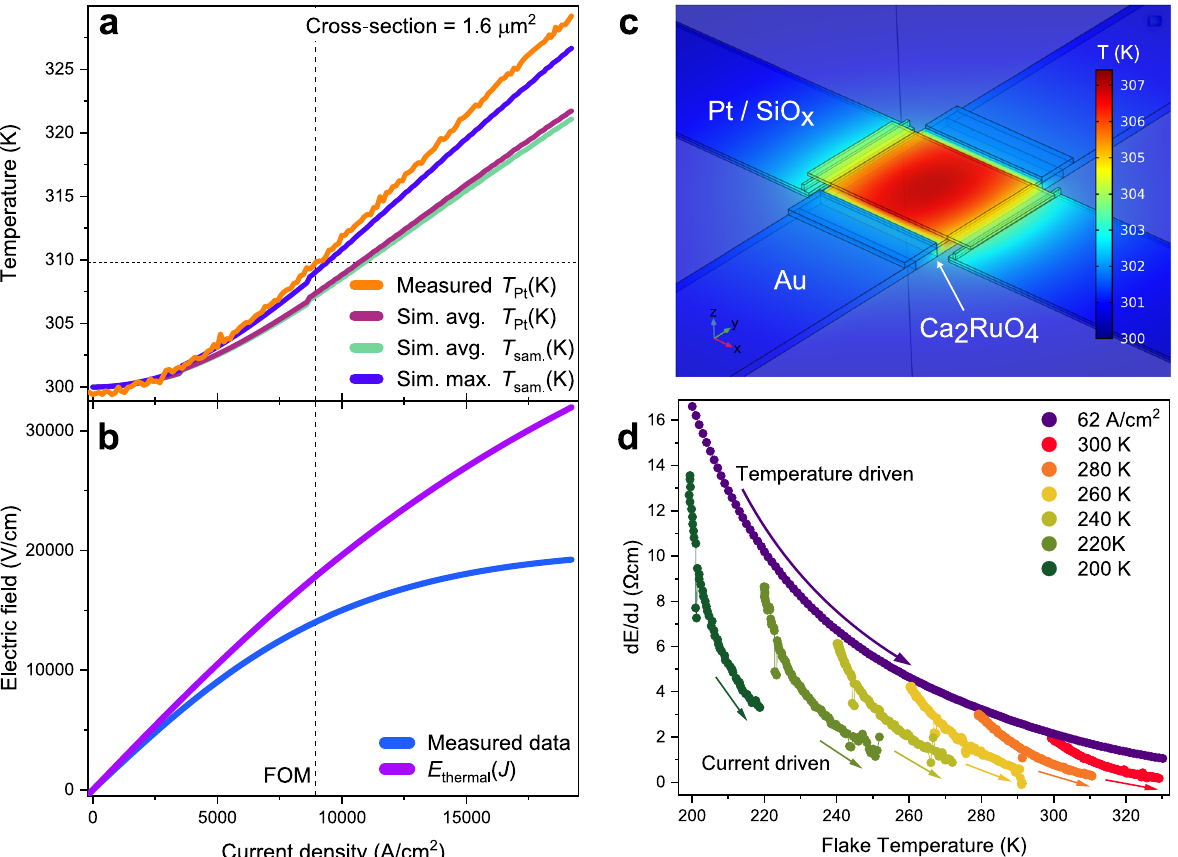
Fig. 3 The role of temperature in microscopic samples. a Displays the local measured Pt temperature and multiple simulated temperatures as a function of the applied J . The data is acquired on the sample depicted in Fig. 1a. The substrate temperature is 300 K. b Shows the electric fi eld acquired simultaneously with the temperature measurement. The measured data is compared to E on basis of Joule heating only). The vertical reference line indicates the FOM. The local temperature increase at the FOM is below 10 K. A simulated temperature heatmap of the sample at the FOM current density is shown in c . d Displays the differential resistivity as a function of the fl ake temperature. Either the background temperature or the current density is changed. At all current densities, the nonlinear conduction is stronger than heating effects can